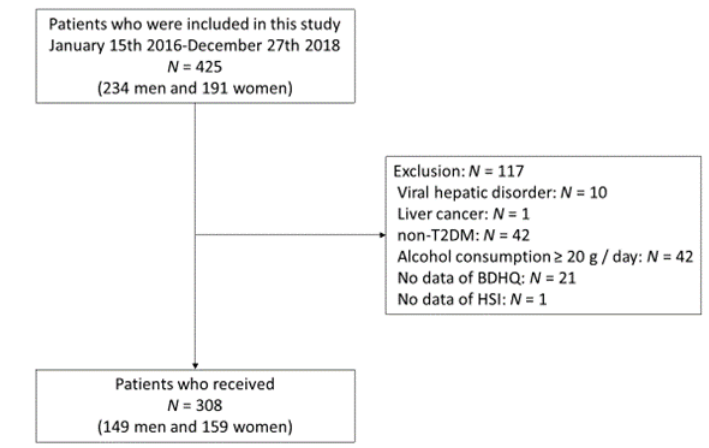
Figure1. Inclusionandexclusionflow. T2DM,type2diabetesmellitus; BDHQ,Brief-typeself-administered diet history questionnaire; HSI, hepatic steatosis